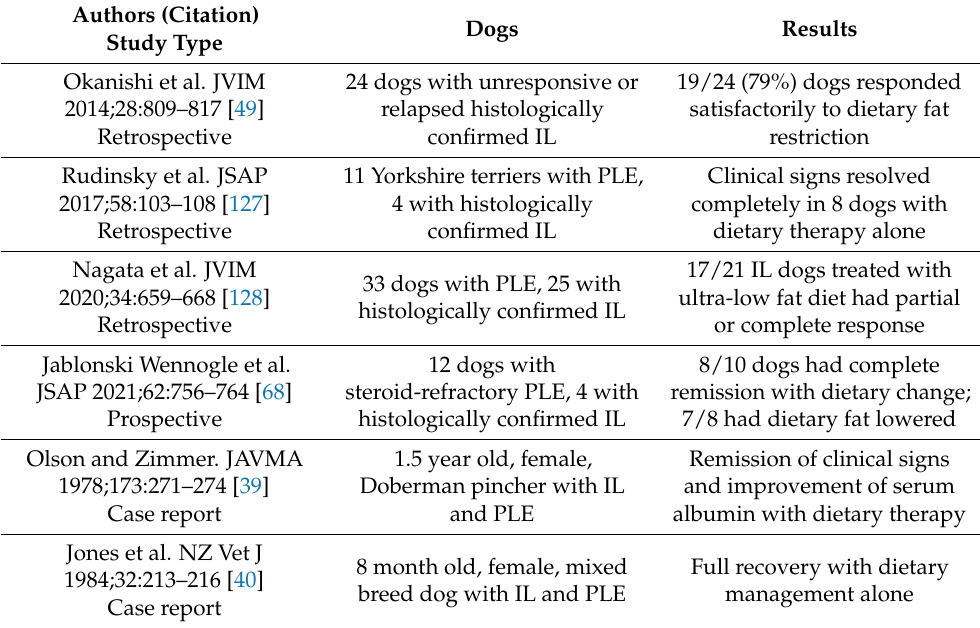
Table 2. Studies reporting on dietary treatment of suspected or confirmed IL in